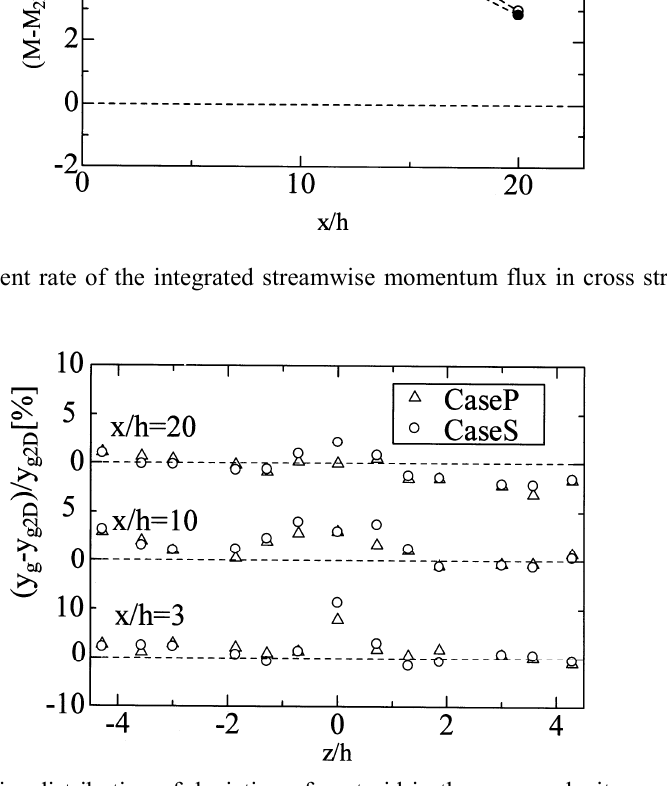
12 Spanwise distribution of deviation of centroid in t dimensional